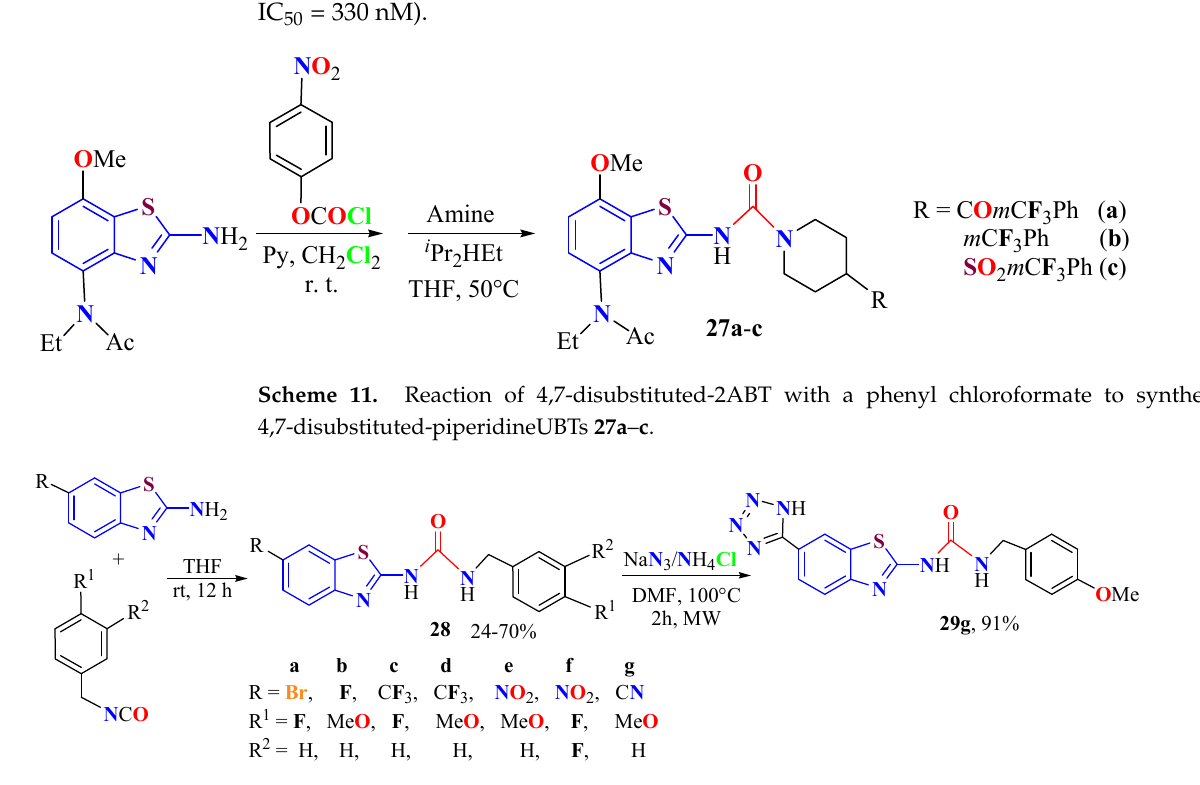
Scheme 12. The 6-substituted benzyl-UBTs 28a – g from 6-substituted-2ABT and the in situ generated benzyl-isocyanates.